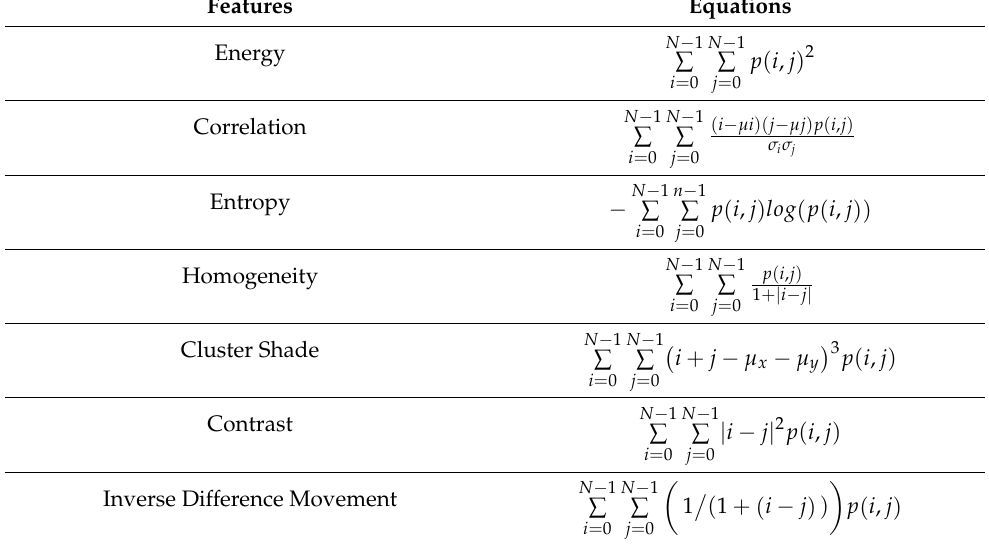
Table 1. Feature Extraction